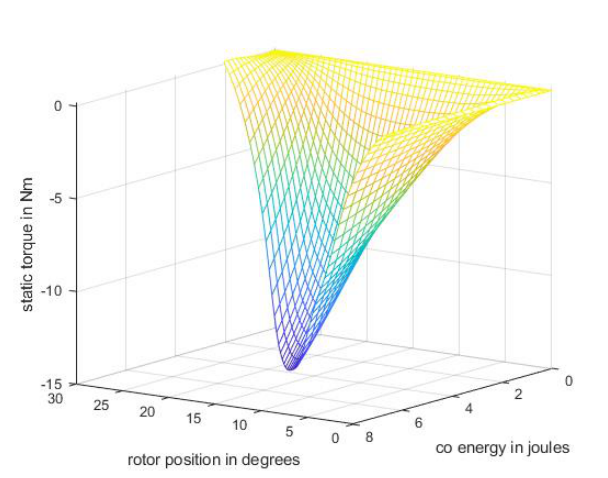
Fig. 4. Variation of Co energy with rotor position and current